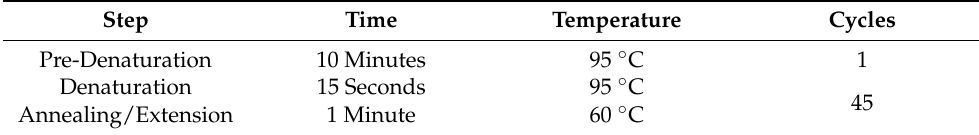
Table 2. Quantitative Real-Time PCR Thermal Profile.